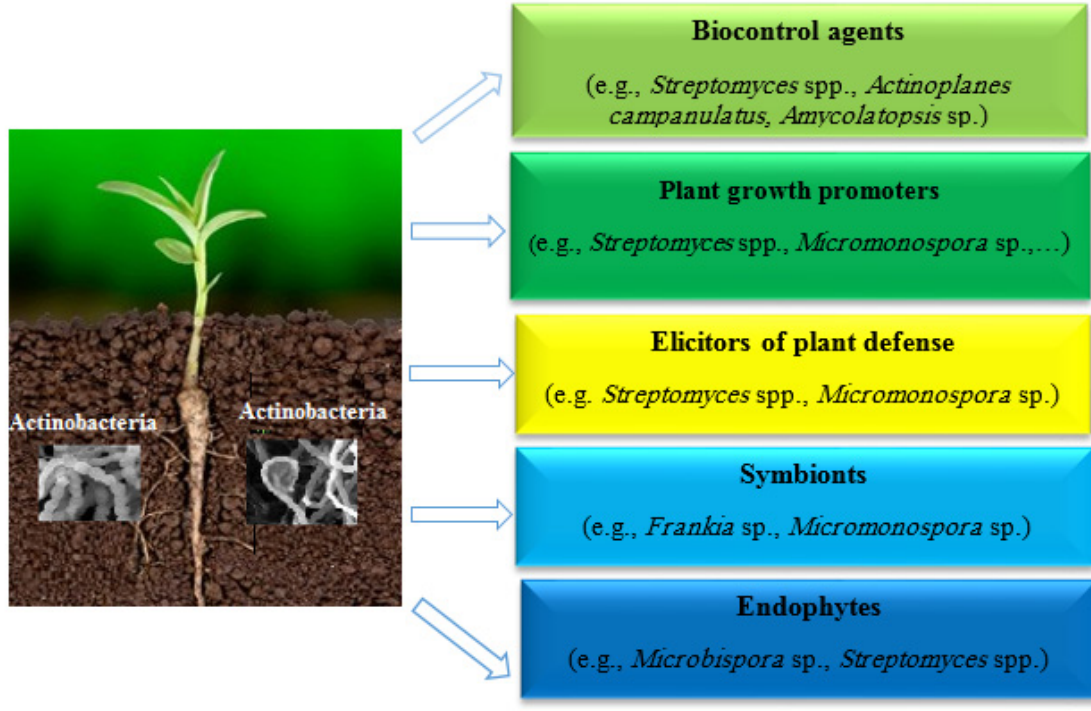
Figure 1. Beneficial interactions of Actinobacteria with plants.